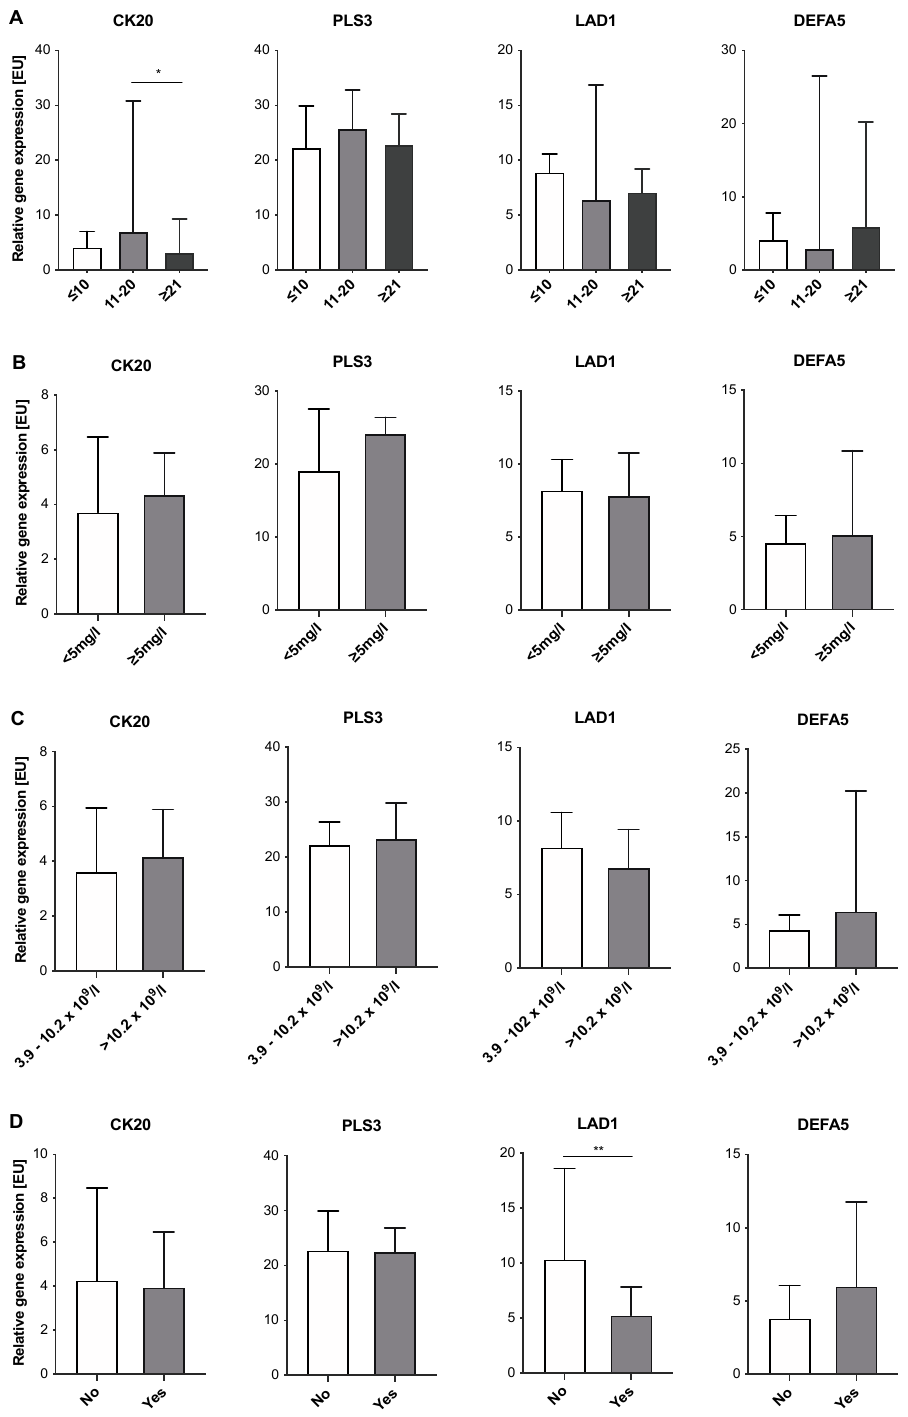
Figure 4. Correlation of expression levels of CTC-associated markers in blood samples of IID patients with clinical parameters of severity of inflammation. MNC-derived cDNA from n = 48 IBD patients (for A + D) and n = 64 IID (for B + C) was analyzed by RT-qPCR for expression of CK20, PLS3, LAD1, and DEFA5. Expression data were correlated with ( A ) duration of disease [years], ( B ) CRP serum concentration [mg/L], ( C ) blood leucocyte count [cells/L] and ( D ) intake of immunosuppressive drugs [yes/no]. Data are presented as median and 95% confidence interval. * p < 0.05; ** p <